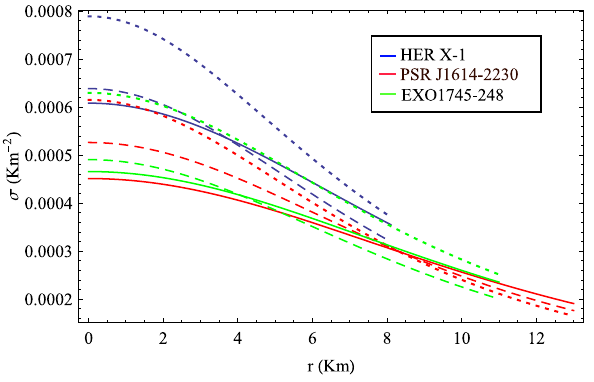
Fig. 9 Radial variation of charge density ( σ ) for different compact objects as indicated in the figure. Here plots with solid, dashed and dotted lines correspond to D = 4 , 5 and 6 respectively. To obtain the plots we choose (i) α = 0 . 4, γ = 0 . 45 when D = 4; α = 0 . 3, γ = 0 . 25 when D = 5 and α = 0 . 25, γ = 0 . 2 when D = 6 for HER X-1, (ii) α = 0 . 4, γ = 0 . 5 when D = 4; α = 0 . 3, γ = 0 . 25 when D = 5 and α = 0 . 2, γ = 0 . 15 when D = 6 for PSR J1614-2230, (iii) α = 0 . 4, γ = 0 . 5 when D = 4; α = 0 . 3, γ = 0 . 2 when D = 5 and α = 0 . 2, γ